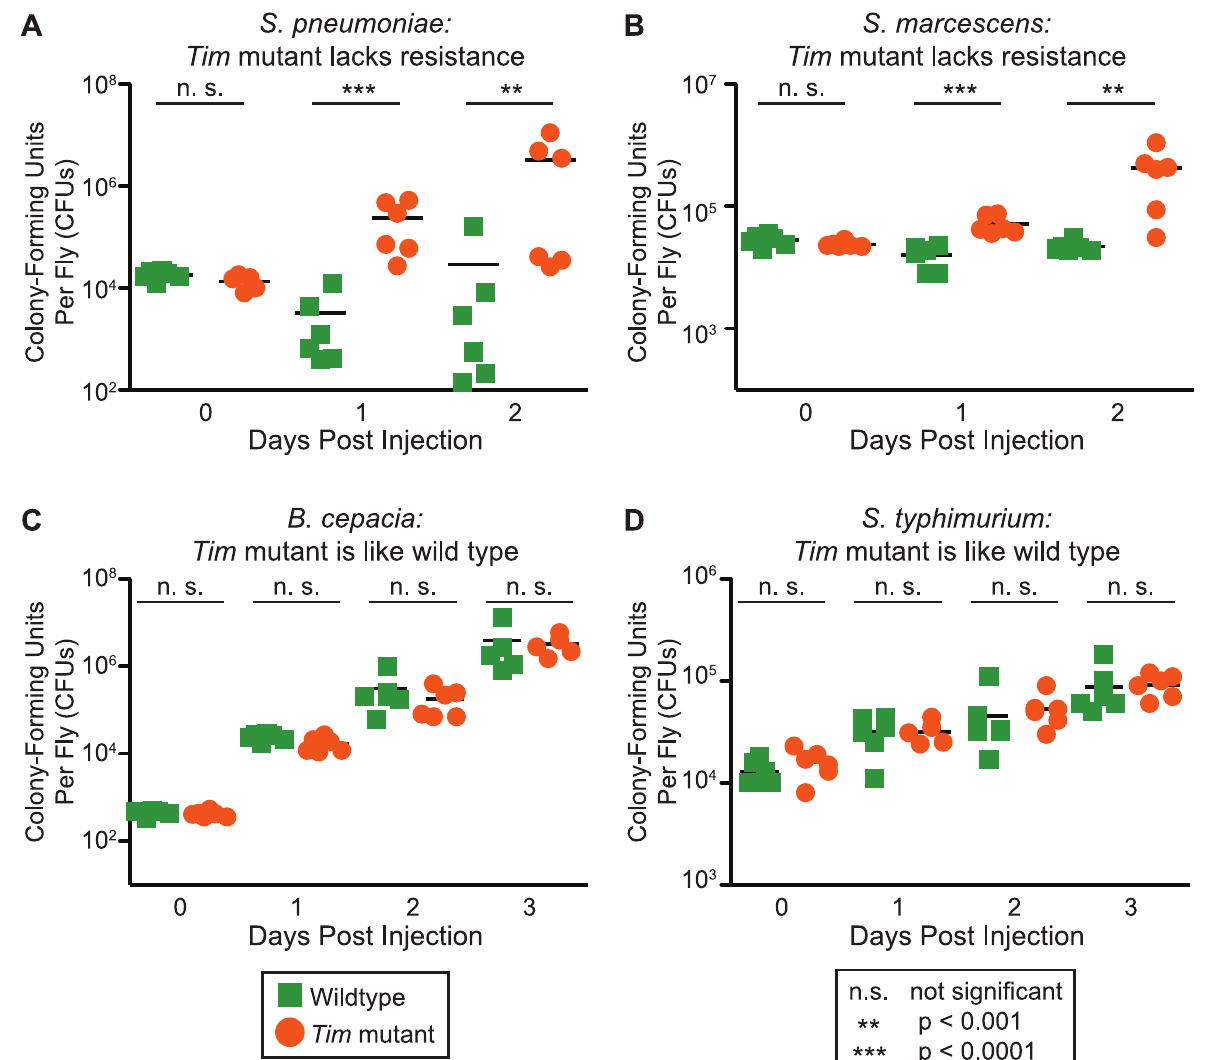
Figure 2. Tim regulates resistance to infection by S.pneumoniae and S.marcescens . Mutants lacking resistance, or bacterial killing, have shorter survival times and greater bacterial loads than wild-type flies. Tim null mutants lack resistance to (A) S. pneumoniae and (B) S. marcescens . Tim mutants have bacterial loads similar to wild-type flies when infected with (C) B. cepacia and (D) S. typhimurium . p-values were obtained by two-tailed, unpaired t-test; all experiments were performed with day-time